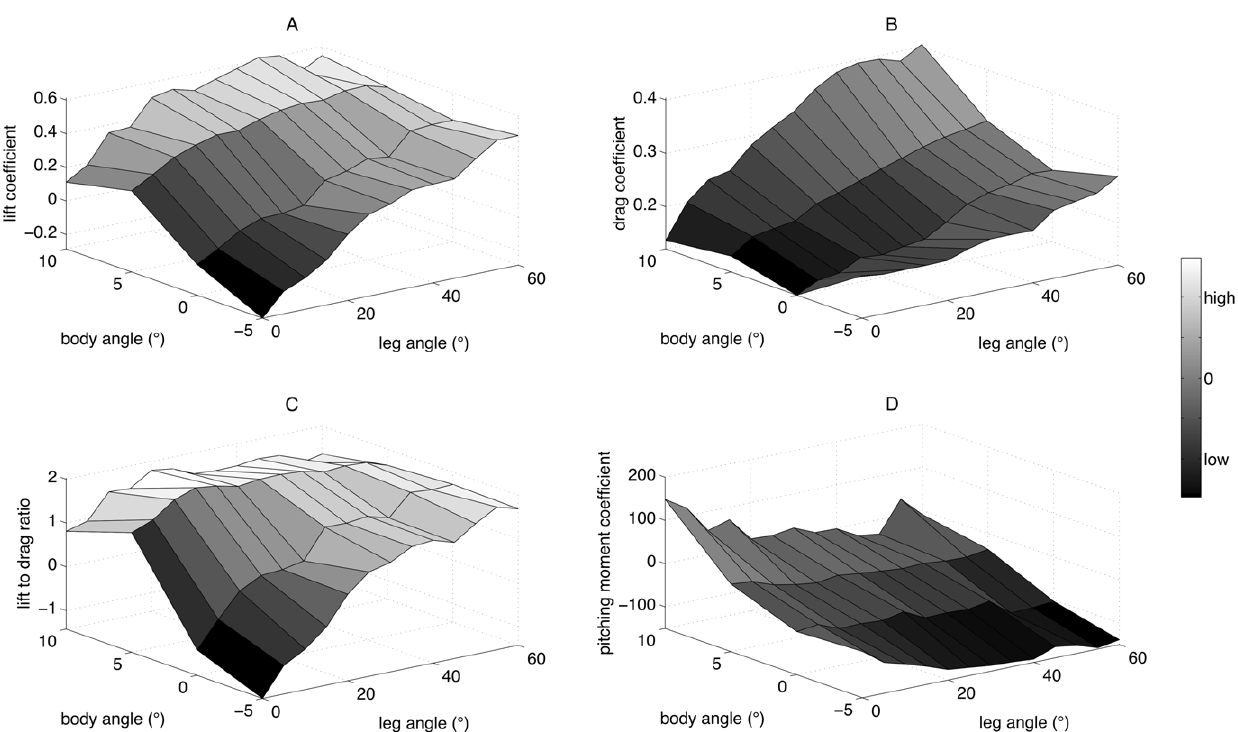
Figure 3. Aerodynamic force and moment coefficients produced by the bat wind-tunnel model. Effect of both leg angle and body angle on the lift coefficient (A), drag coefficient (B), lift to drag ratio (C) and the pitching moment coefficient (D) generated by the bat model with tail membrane present during wind-tunnel tests. Darker grey indicates lower values, while lighter grey higher values.